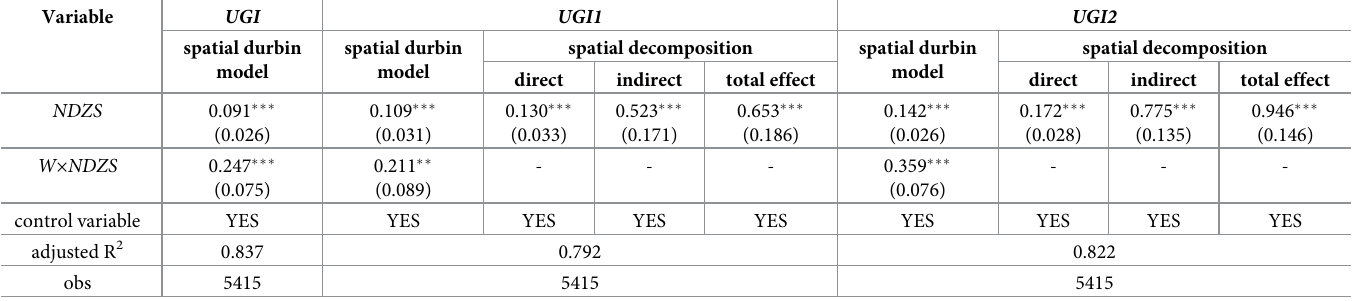
Table 10. Lagging effects of